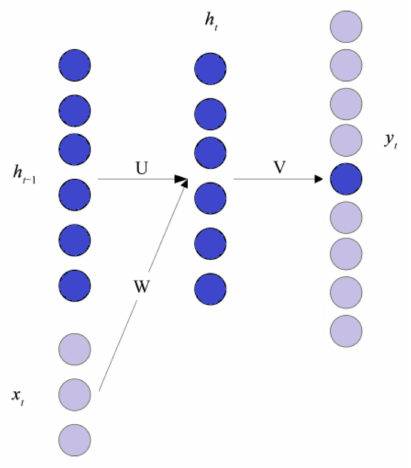
Figure 4. Recurrent neural network.